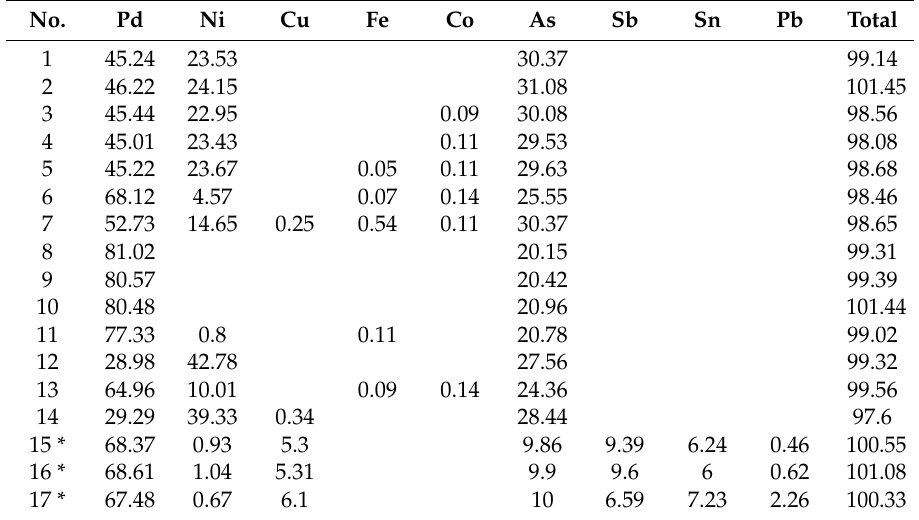
Table 9. Mineral compositions in the system Pd-Ni-As of the Southern 2 orebody, wt %. No. Pd Ni Cu Fe